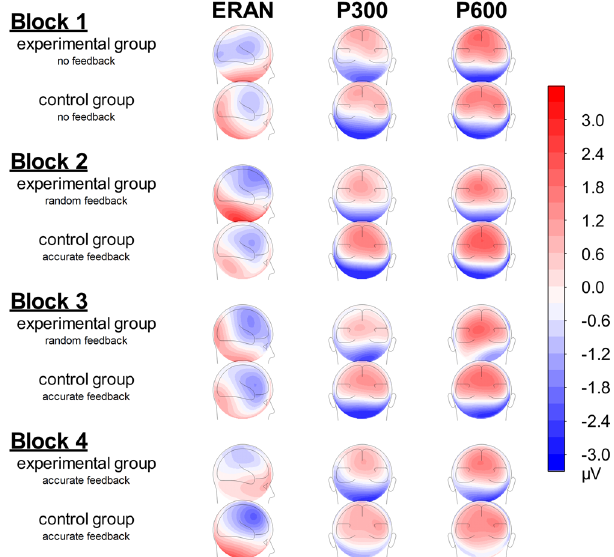
Figure 4. Scalp topographies for the ERAN (100–250 ms), P300 (350–525 ms), and P600 (525–700 ms) in the four experimental